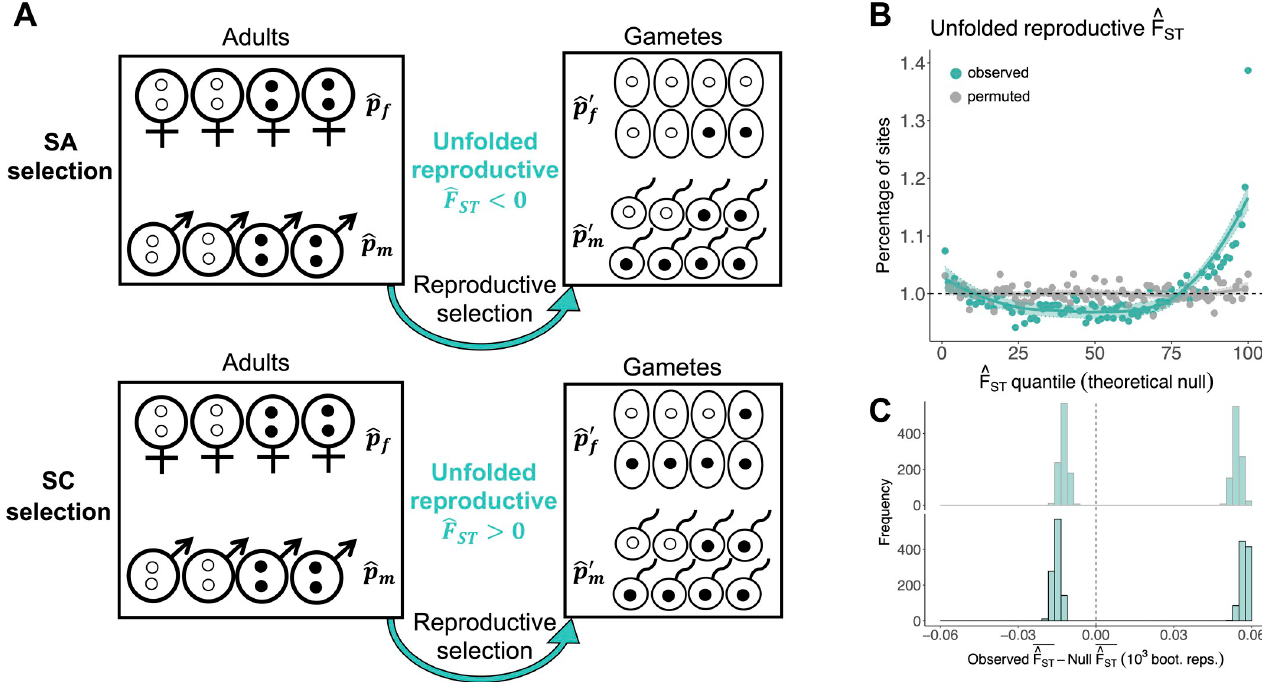
Fig 3. Partitioning signals of sex-differential selection into SA and SC components reveals their joint contributions. ( A ) As in Fig 1, ^ p ; ^ p ; ^ p 0 , and ^ p 0 f m f m depict sex-specific frequency estimates for a given allele at different stages of the life cycle. Under SA selection (top), the white allele is female-beneficial and the black allele is male-beneficial, which tends to generate negative values of unfolded reproductive ^ F . Under SC selection (bottom), the black allele is beneficial ST . ( B ) Percentage of sites (turquoise: observed; grey: permuted) falling into in both sexes, which tends to generate positive values of unfolded reproductive ^ F ST each of 100 quantiles of the theoretical null distributions of unfolded reproductive ^ F . Theoretical null data ( x -axes) were generated by simulating values ST (nSNPs = 1,051,949) from the null (i.e., the product of 2 standard normal distributions). In the absence of sex-differential selection, approximately 1% of observed SNPs should fall into each quantile of the null (dashed line). LOESS curves ( ± SE) are presented for visual emphasis. ( C ) Difference, for unfolded reproductive ^ F , between the mean observed and empirical null data (top) and between observed and theoretical null data (bottom), across 1,000 bootstrap ST replicates. The vertical line intersects zero, indicating no difference between the observed and null data. Differences between observed and null data were obtained separately for negative and positive values of unfolded reproductive ^ F . This illustrates that there is enrichment of SNPs in both tails of the null. The ST code and data needed to generate this figure can be found at https://github.com/filipluca/polygenic_SA_selection_in_the_UK_biobank and https://zenodo.org/ record/6824671. SA, sexually antagonistic; SC, sexually concordant; SNP, single-nucleotide